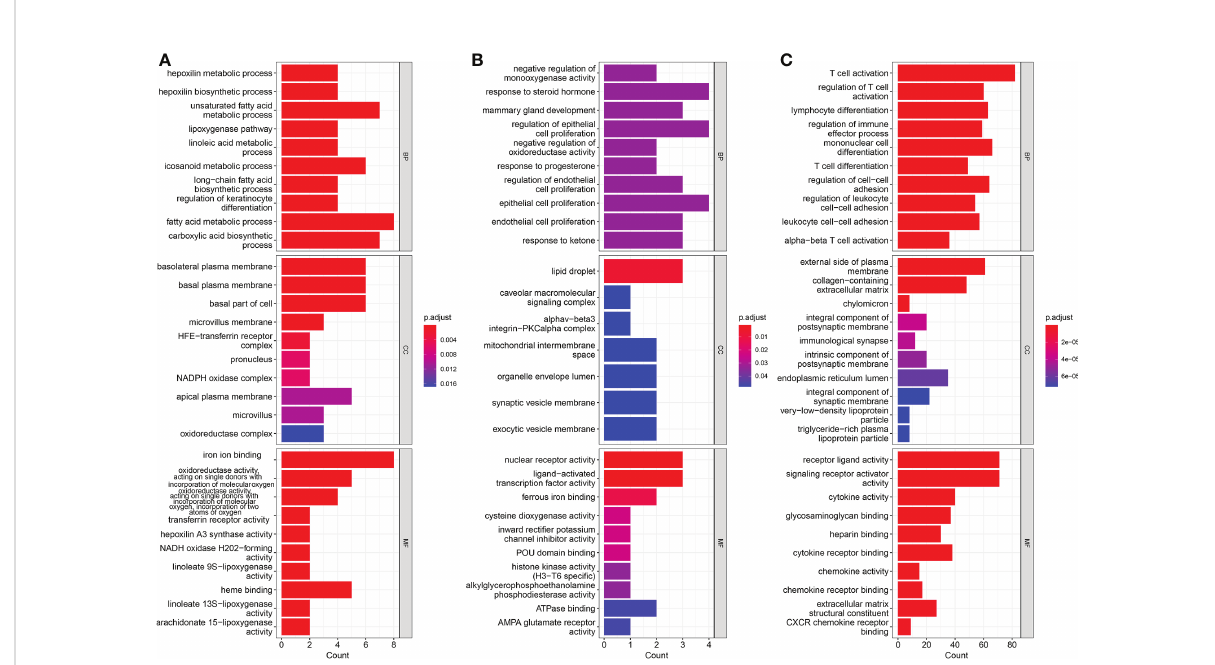
FIGURE 5 Results of Gene Ontology (GO) pathway enrichment analyses of differentially-expressed genes (DEGs) among (A) up-regulated genes and (B) down-regulated genes. (C) Results of GO pathways enrichment analyses of DEGs among low risk and high risk